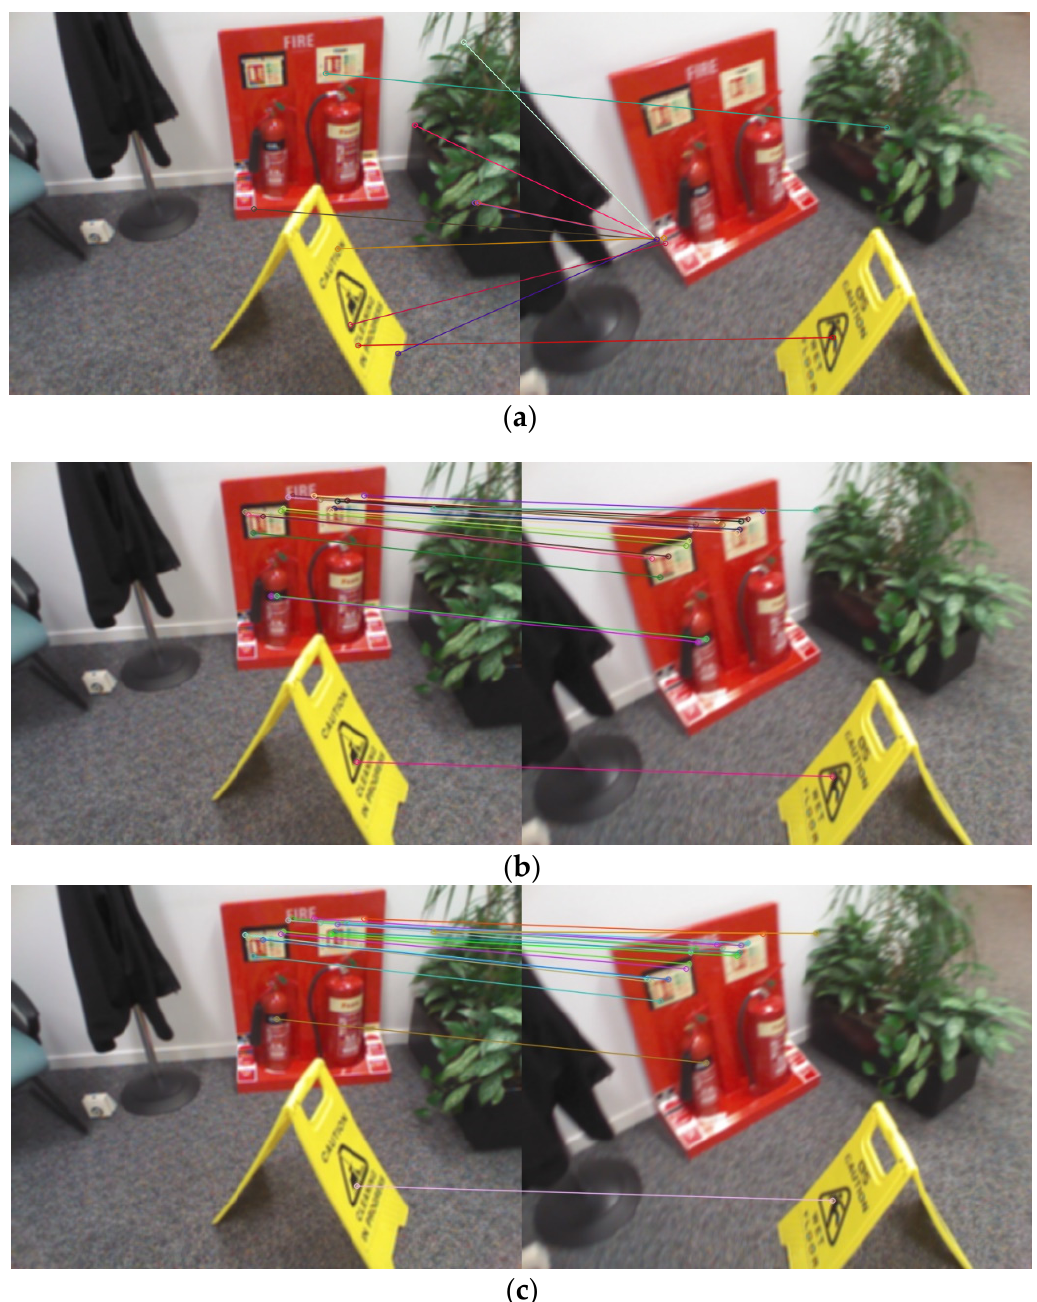
Figure 14. Example of successful registration of ORBPFH and ORBFPFH but failed registration of ORB. ( a ) ORB registration of frames 1 and 227 in the YCB 0024 dataset. ( b ) ORBPFH registration of frames 1 and 227 in the YCB 0024 dataset. ( c ) ORBFPFH registration of frames 1 and 227 in the YCB 0024 dataset.